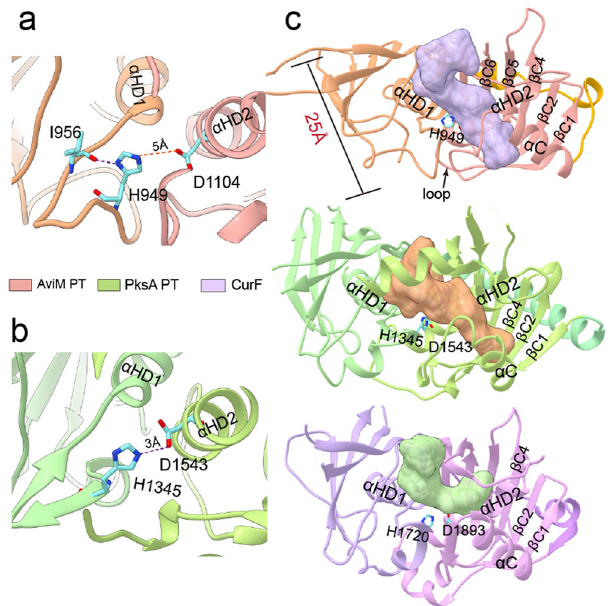
Fig. 4 The active site of AviM PT. a The N δ of the catalytic H949 forms a hydrogen bond with the backbone carbonyl of I956 in AviM PT. b The N ε of the catalytic H1345 forms a hydrogen bond with the side chain of the catalytic D1543 in PksA PT. c The substrate tunnel of AviM PT is different from that of PksA PT and CurF. The cartoon structure of AviM PT, PksA PT and CurF are shown in orange, green and purple, respectively. The substrate tunnel of AviM PT, PksA PT and CurF are shown in purple, orange and green,